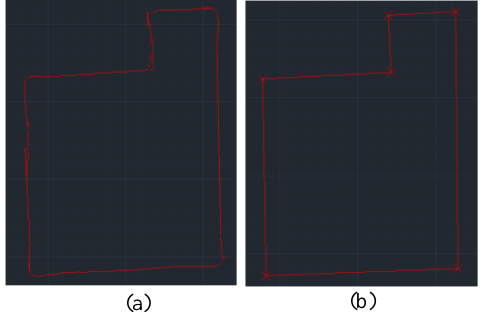
Figure 25. Room case: 2D projection lines of the walls (a) before adjustment and connection, (b) after adjustment and connection and marking of the edges.